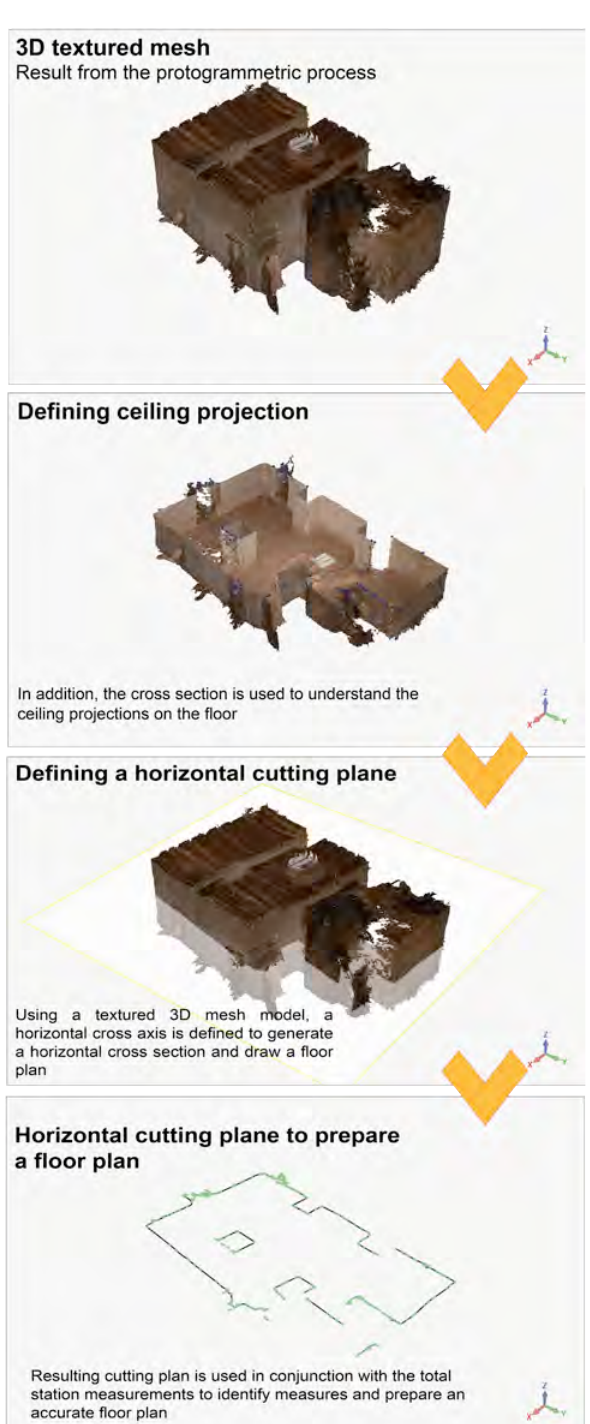
Figure 5: defining a cutting plane to survey the ceiling projections and preparing a floor plan.